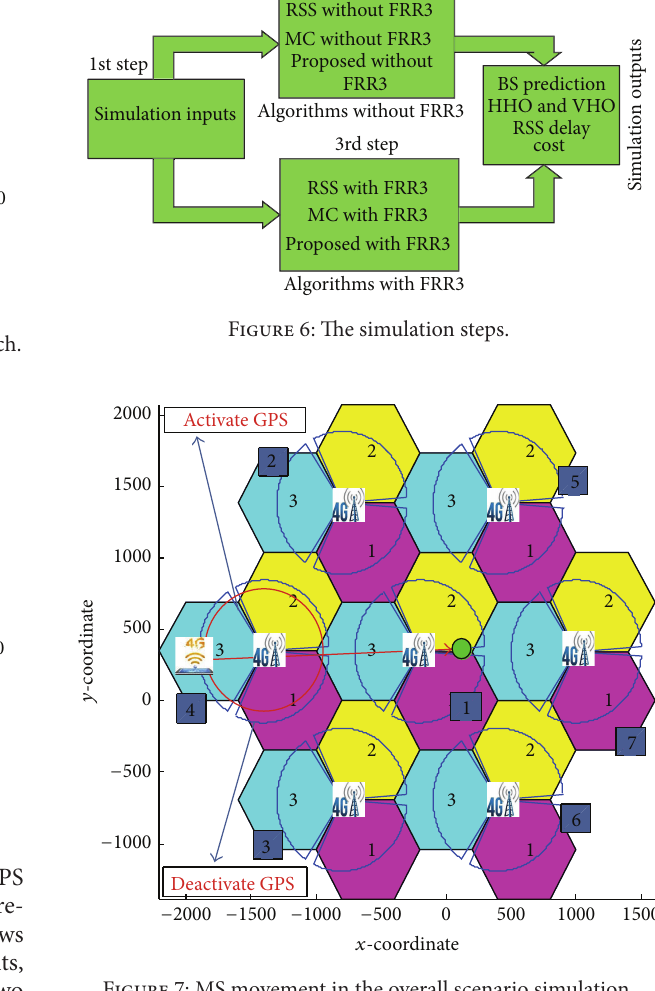
Figure 7: MS movement in the overall scenario